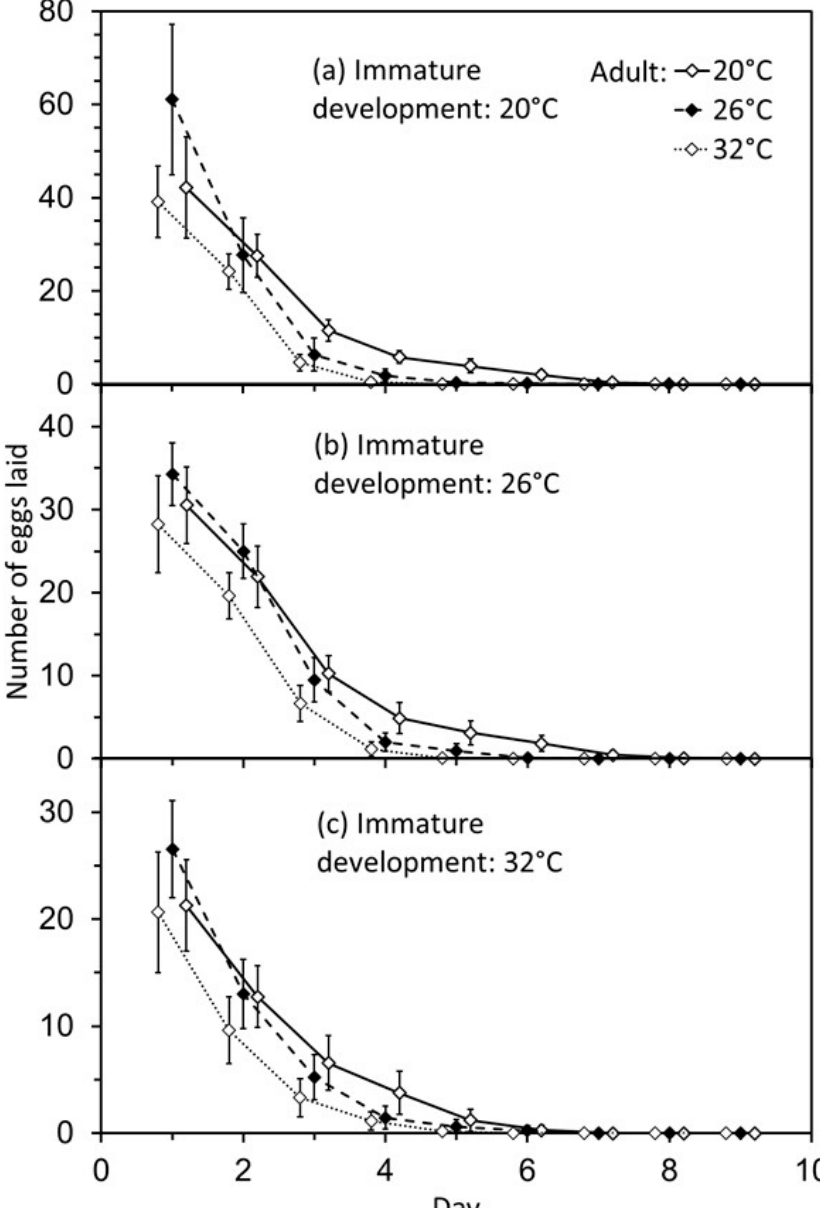
Figure 4. Effects of temperature during immature development and the adult stage on the daily oviposition of Eretmocerus warrae . ( a ) Immature development at 20 °C. ( b ) Immature development at 26 °C. ( c ) Immature development at 32 °C. Values are mean + standard deviation. Values are offset by ±0.15 days to assist visualisation ( p < 0.001).